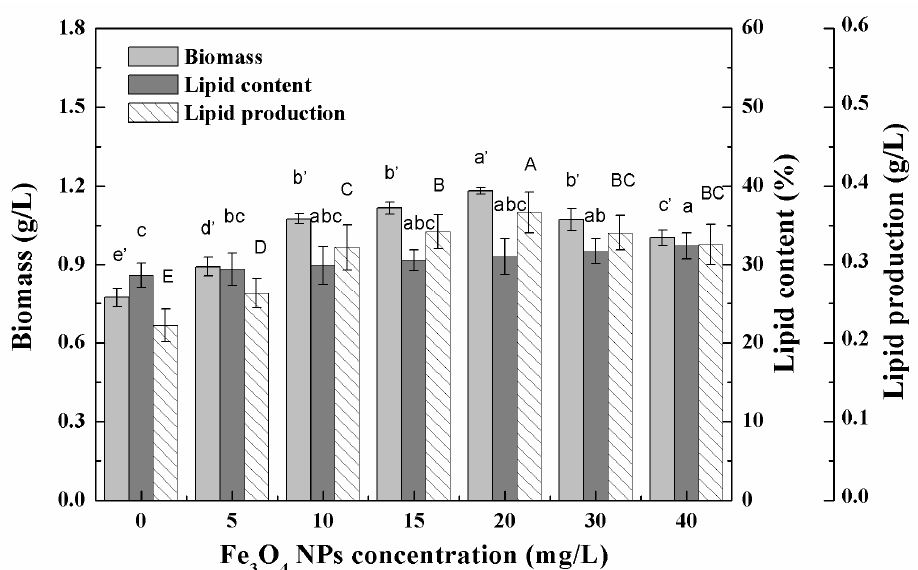
Figure 4. Biomass, total lipid contents, and lipid production of Chlorella sp. UJ-3 exposed to various concentrations of Fe 3 O 4 NPs (Culture time: 21 days; Different letters on the top of column indicate significant differences between means: a, b, c, d; a’, b’, c’, d’; A, B, C, D; p < 0.05 ).